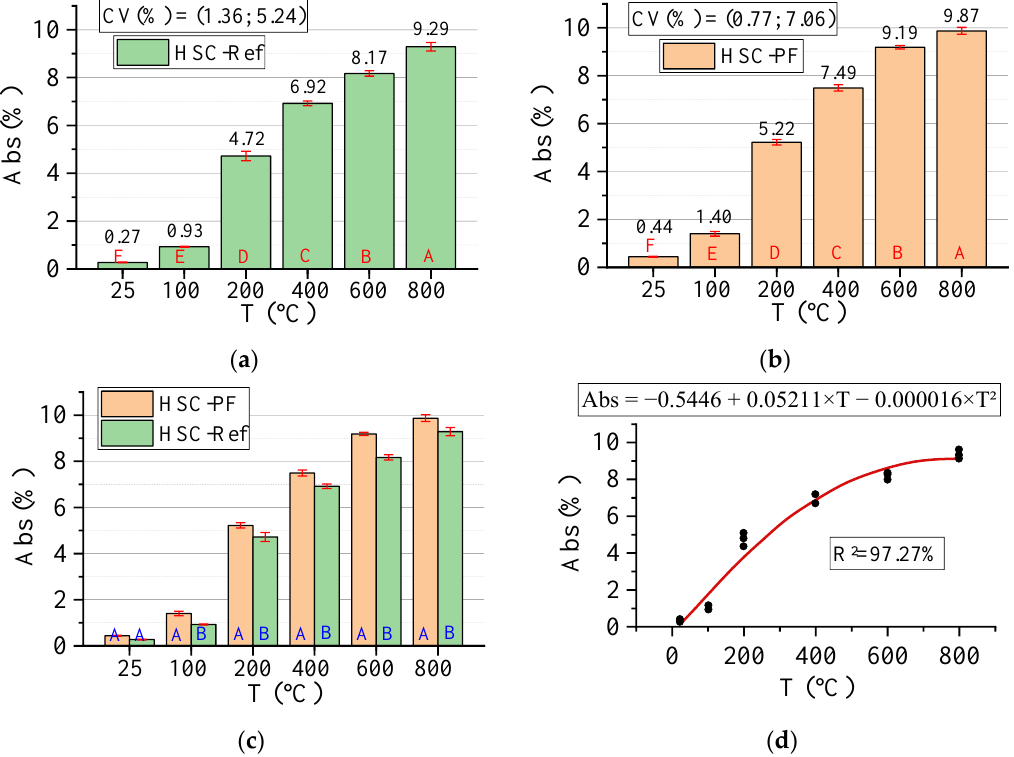
Figure 12. Summary of absorption (Abs) results: ( a ) Tukey’s test for the samples without polypropylene fibers, ( b ) Tukey’s test for the samples with polypropylene fibers, ( c ) Tukey’s test for the samples without and with polypropylene fibers and ( d ) Quadratic regression model fit to the experimental data set considering only the effect of temperature as an independent factor. The uppercase letters A – F in figure mean equivalence between the sample results.